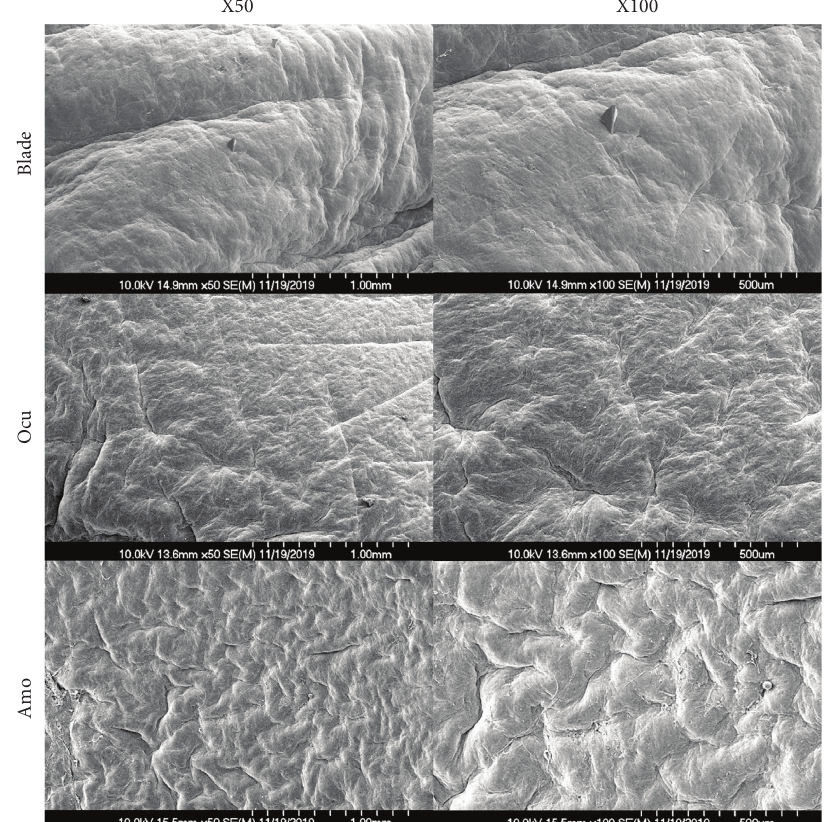
Figure 5: Residual stromal surfaces investigated by scanning electron microscopy (SEM) in the three groups (50x and 100x